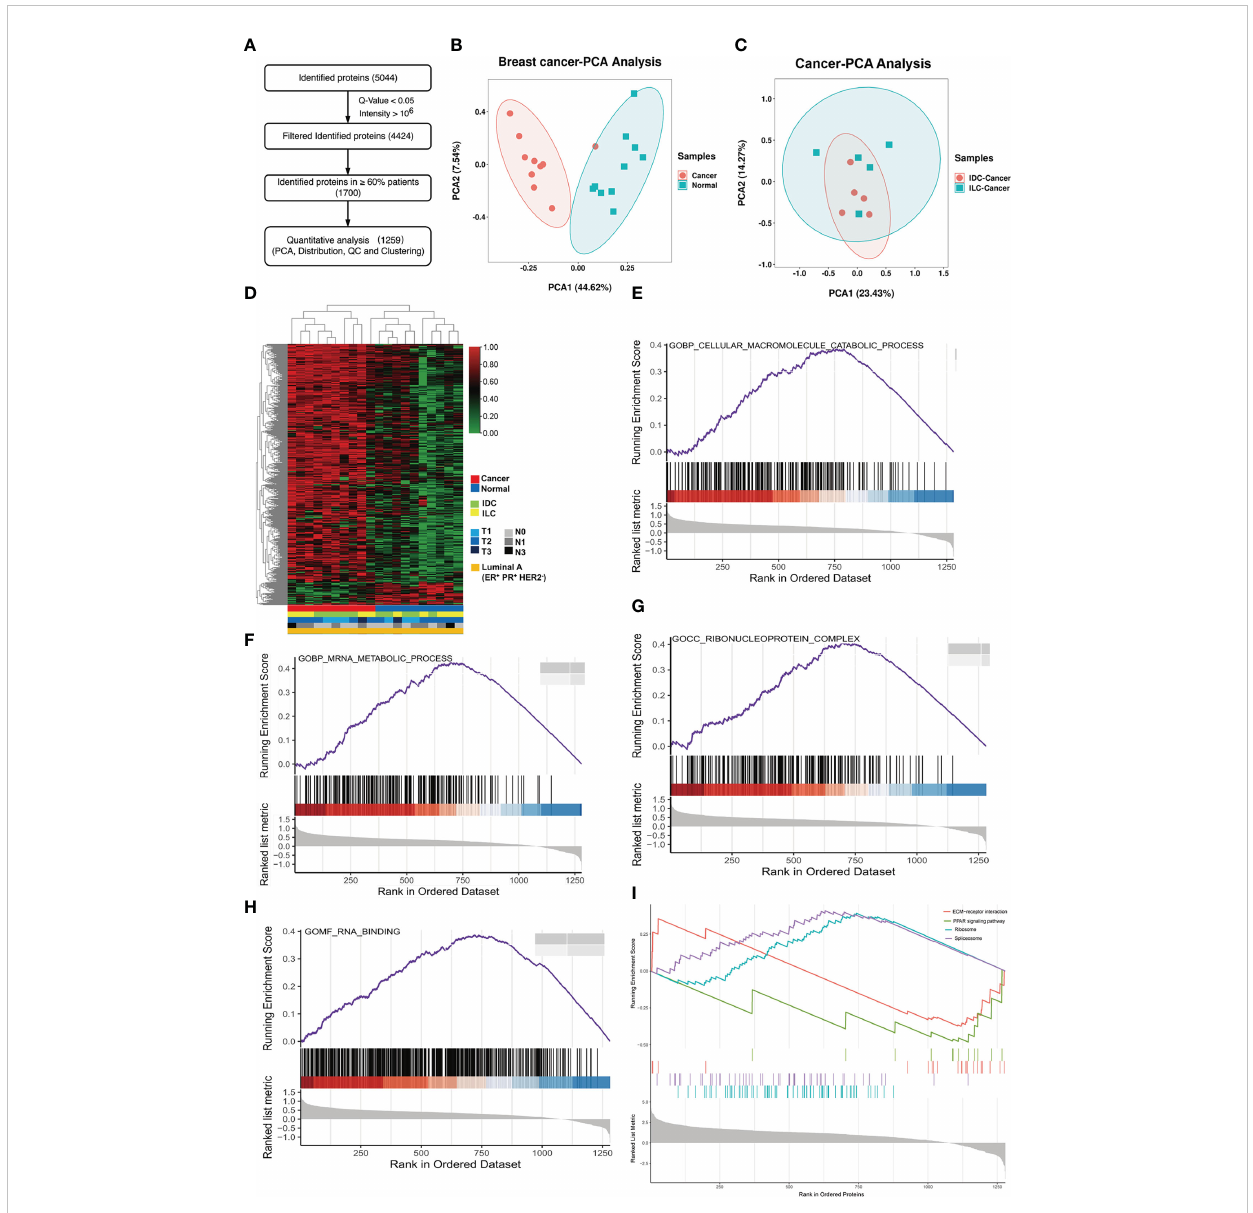
FIGURE 1 Proteome characterization of luminal A breast cancer. (A) Flowchart of data fi lter and normalization analysis of proteins identi fi ed from luminal A breast cancer. (B) PCA of 1,259 proteins in 10 paired luminal A breast cancer tissues. Red: tumor, and green: NAT. (C) PCA of 1,259 proteins identi fi ed from the cancer and NATs tissues. Red: IDC cancer, and green: ILC cancer. (D) Heatmap of proteins in tumors and NATs and their associated clinical information showing expression of proteins in cancer or NAT samples. (E-H) GSEA results of luminal A breast cancer tissues revealed Gene Ontology (biological process, cellular component, molecular function) results associated with important metabolic functions. (I) GSEA plots revealed KEGG pathways associated with classical cancer